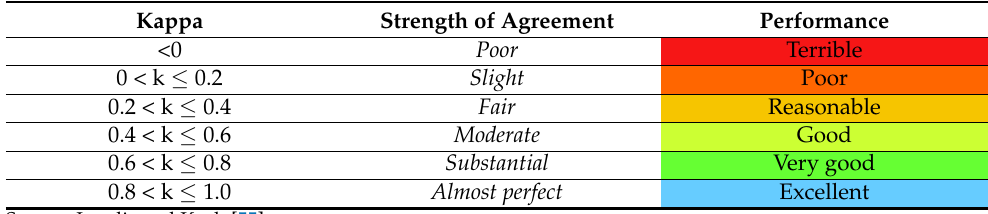
Table 4. Reference to interpret the classification performance based on the kappa index value. Kappa Strength of Agreement Performance <0 Poor Terrible 0 < k ≤ 0.2 Slight Poor Fair Reasonable Moderate Good 0.6 < k ≤ 0.8 Substantial Very good Almost perfect